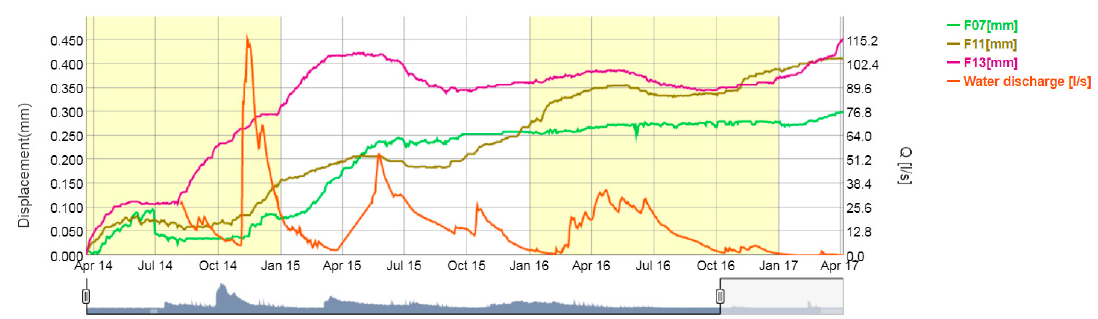
Figure 9. Displacement recorded by crackmeters F07, F11 and F13 plotted with the water discharge recorded in the drainage system within the road tunnel—the graph has been produced directly from the web-based platform.